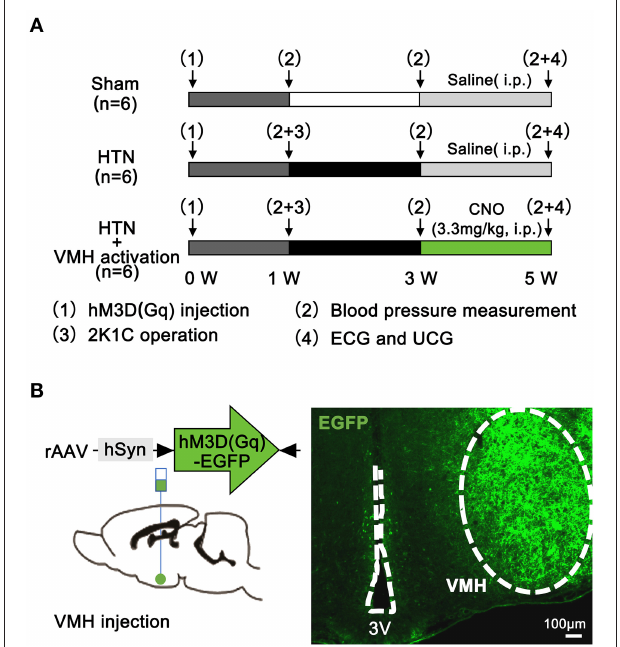
FIGURE 1 | Experimental protocol and pharmacogenetics method. (A) Experimental protocol ( n = 6 per group); (B) Schematic diagram and representative image showing virus injection and hM3D(Gq)-EGFP expression in the VMH at 3 weeks. The scale bar represents 100 µ m. VMH, ventromedial hypothalamus; ECG, electrocardiogram; UCG, ultrasonic cardiogram; CNO, clozapine-N-oxide; 3V, the third